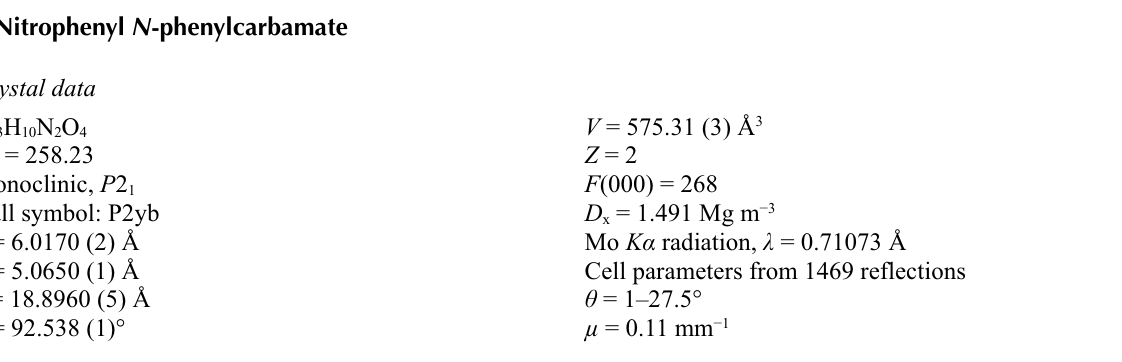
Figure 2 A packing diagram of (I) along a